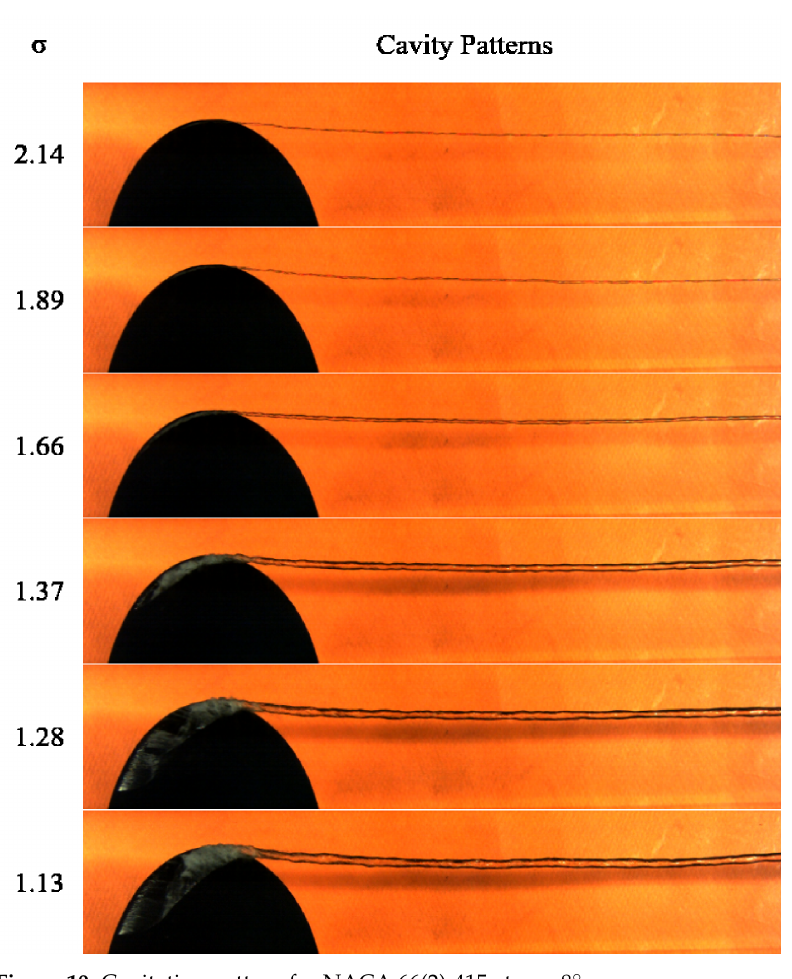
Figure 10. Cavitation pattern for NACA 66(2)-415 at α = 8 ◦ .